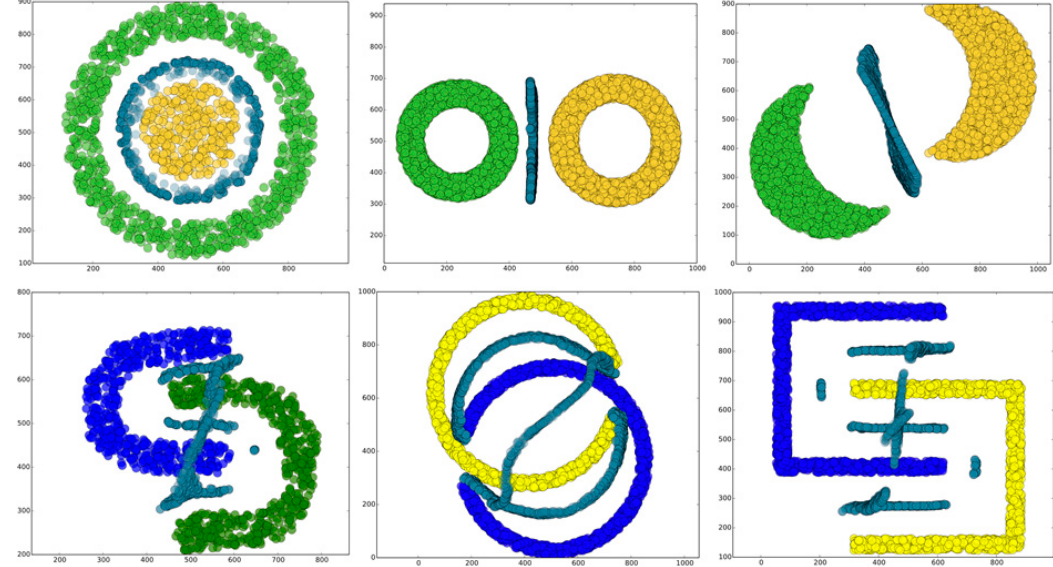
Figure 4. Screenshots of the discovered ignorance zones (set of grey points) for the artificial datasets (two differently colored data manifolds) in 2D with the k NDN algorithm.